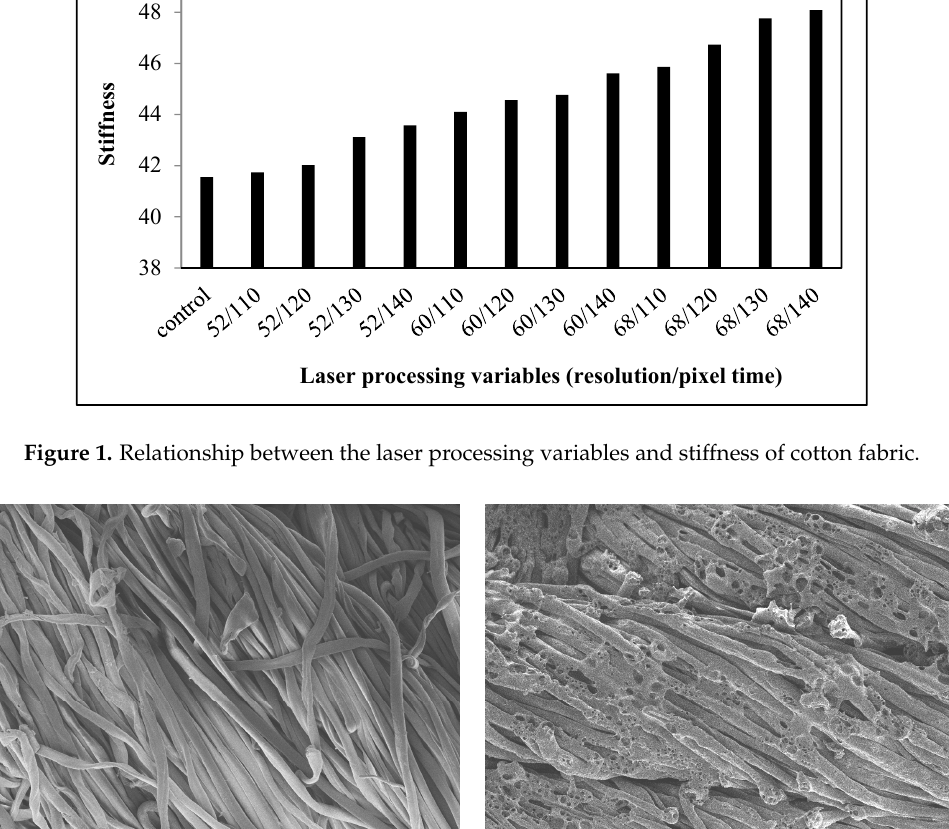
Figure 1. Relationship between the laser processing variables and stiffness of cotton fabric.